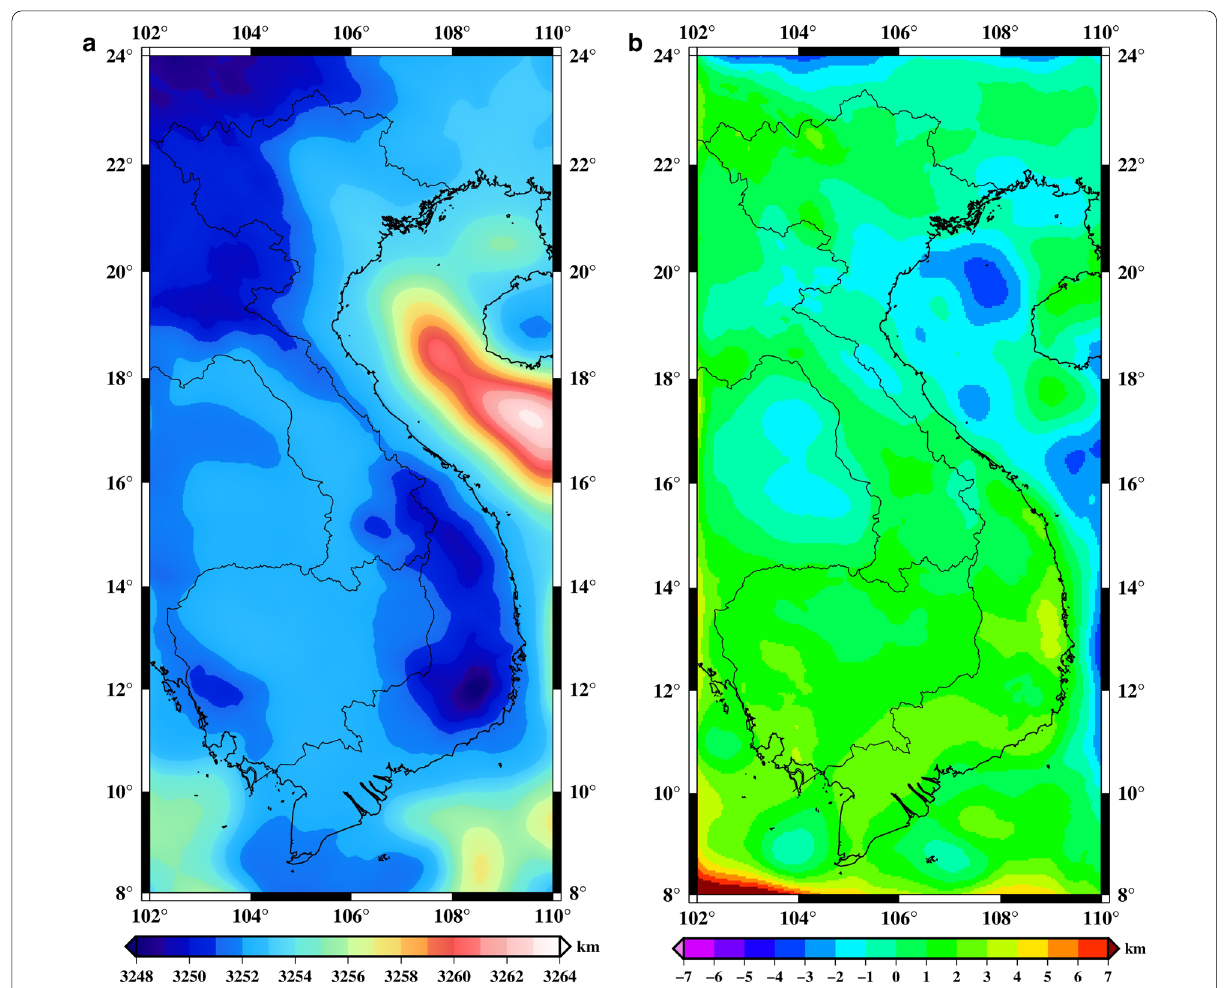
Fig. 11 a Average value of the lithospheric mantle density and b differences between Moho_GEOID and Moho_GRAVITY